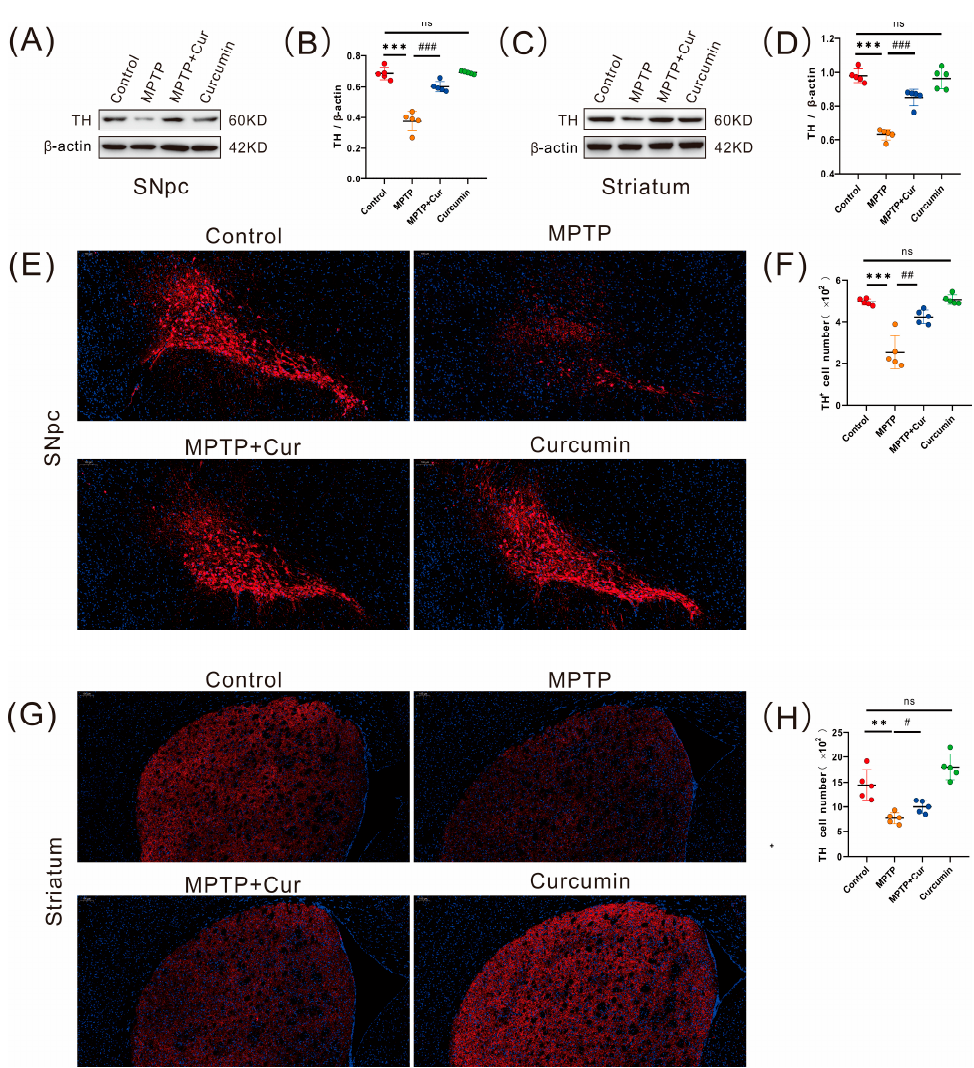
Figure 2. Curcumin treatment reduced MPTP-induced Dopaminergic Neuronal Degeneration in PD mice. ( A – D ) Quantification of TH expression in the SN and striatum by Western blot in the four groups ( n = 5); ( E,G ) Representative immunofluorescence images of TH-positive cells in the SN and striatum of the four groups; ( F,H ) Quantitative analysis of TH-positive regions in the SN and striatum in the four groups ( n = 5). The quantitative analysis of the TH-positive regions was performed using ImageJ. All statistical differences were tested using a t -test ( B , D , F , H ). Data are expressed as the mean ± SEM ( n = 5/group).The significance is expressed as ** p < 0.01, and *** p < 0.001 vs. control group. # p < 0.05, ## p < 0.01, and ### p < 0.001 vs. MPTP group.n.s., not significant.